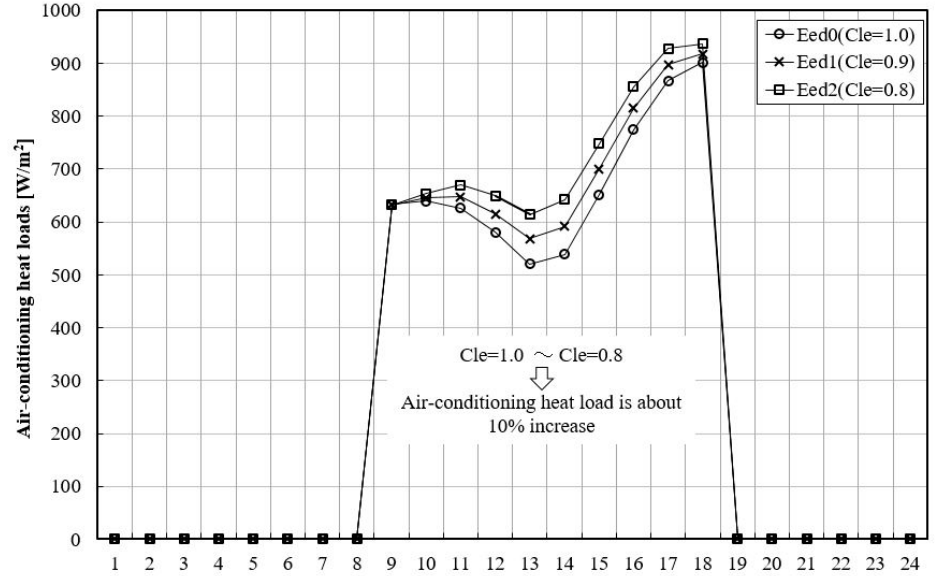
Figure 13. Impact of cloudless index ( Cle ) on air-conditioning heat load of buildings when the index of Cle varied from 1.0 to 0.8.